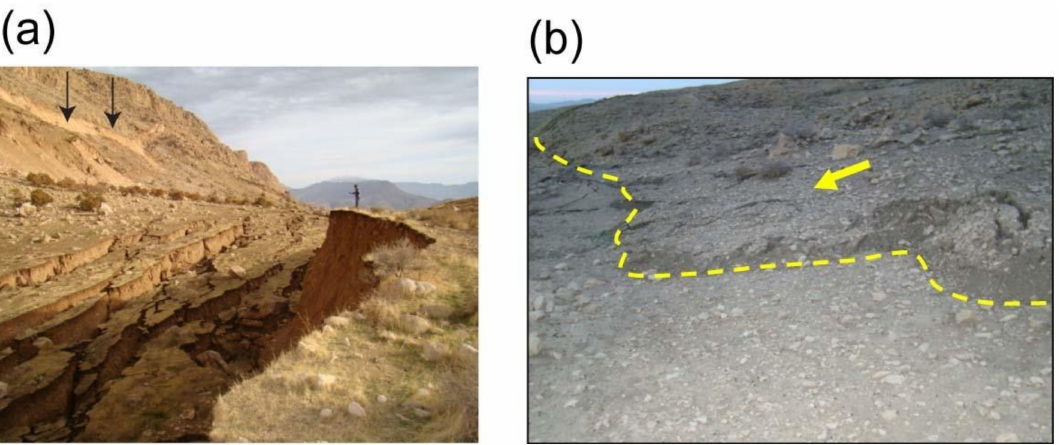
Figure 10. ( a ) Horst and graben structures due to normal faulting at the top of the Mela-Kabod landslide. The black arrows mark the scarp of a strike-slip fault. ( b ) The toe of the Mela-Kabod landslide and its direction of